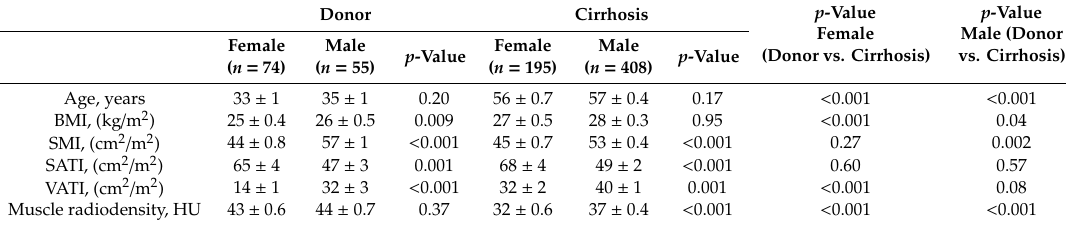
Table 1. Body composition features of healthy donors and patients with cirrhosis by sex.